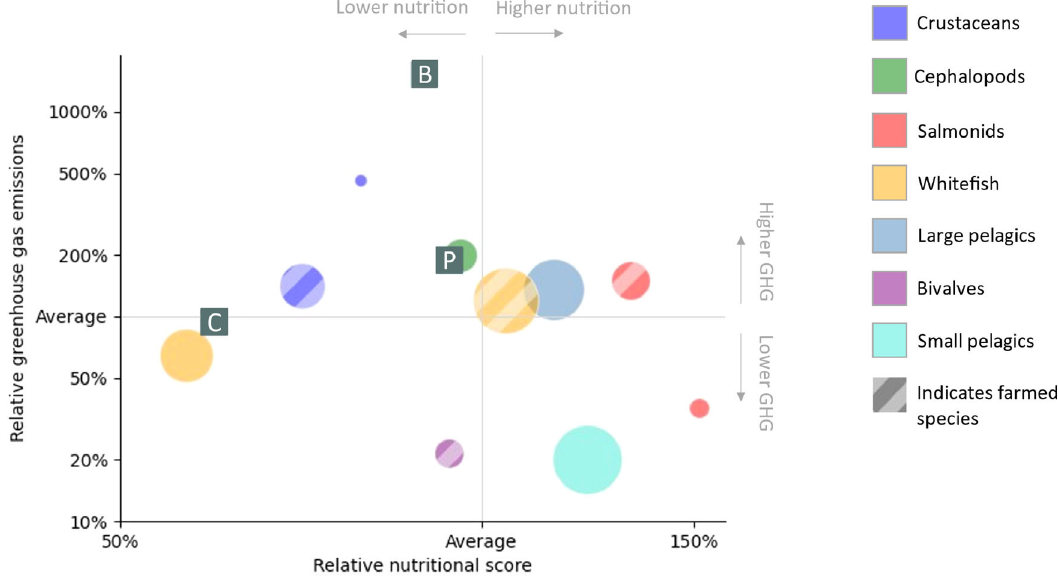
Fig. 1 Nutrient density and greenhouse gas emissions of globally important seafood groups. Relative nutrient density and production-related GHG emissions (i.e. post-harvest emissions are excluded) per edible weight of globally important seafood groups from fi sheries (solid colours) and aquaculture (striped) at the point of landing or harvest, along with beef (B), chicken (C) and pork (P). Relative size of seafood group bubbles is proportionate to 2015 global edible weight production volumes, and GHG and nutrient density values are weighted by species. Both GHG values and nutrition scores are log- weighted and positioned relative to the weighted average of all included seafood species (3.7 kg CO 2 e per kg edible weight and NDS 4.0). For graphs showing species in each species group individually, see Supplementary Figs. 1 –